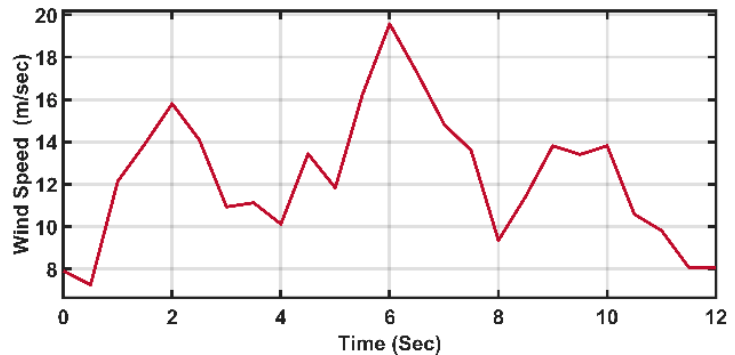
Figure 11. Wind-speed profile of normal first case.